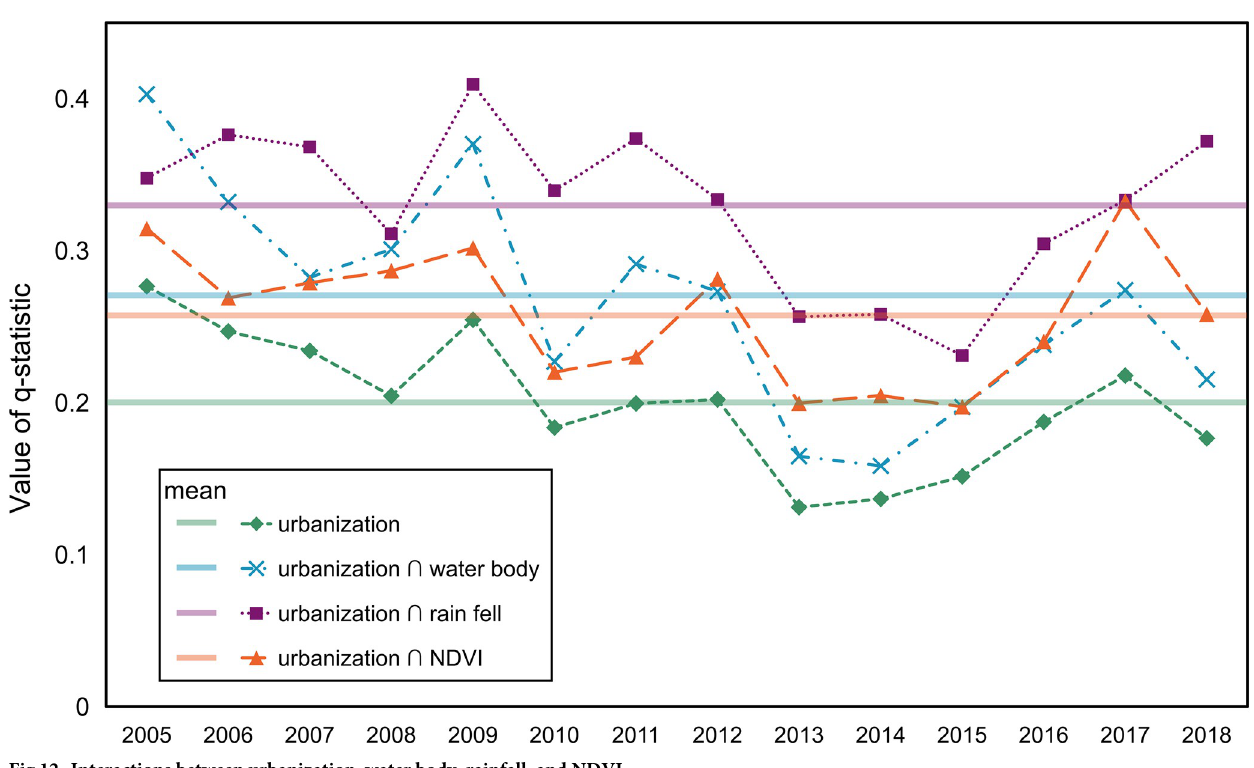
Fig 12. Interactions between urbanization, water body, rainfall, and